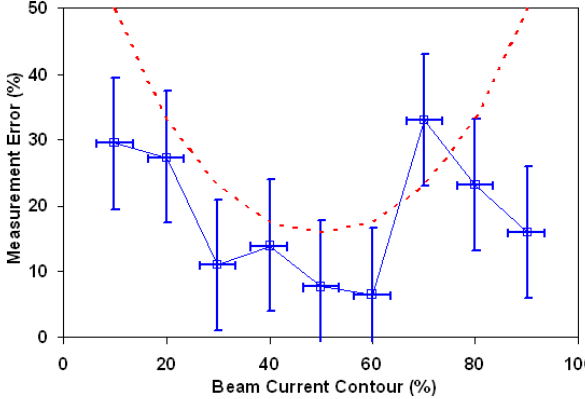
FIG. 14. (Color) Estimated (red dashed line) and measured (blue squares with error bars) errors of the measurements for different SNS beam